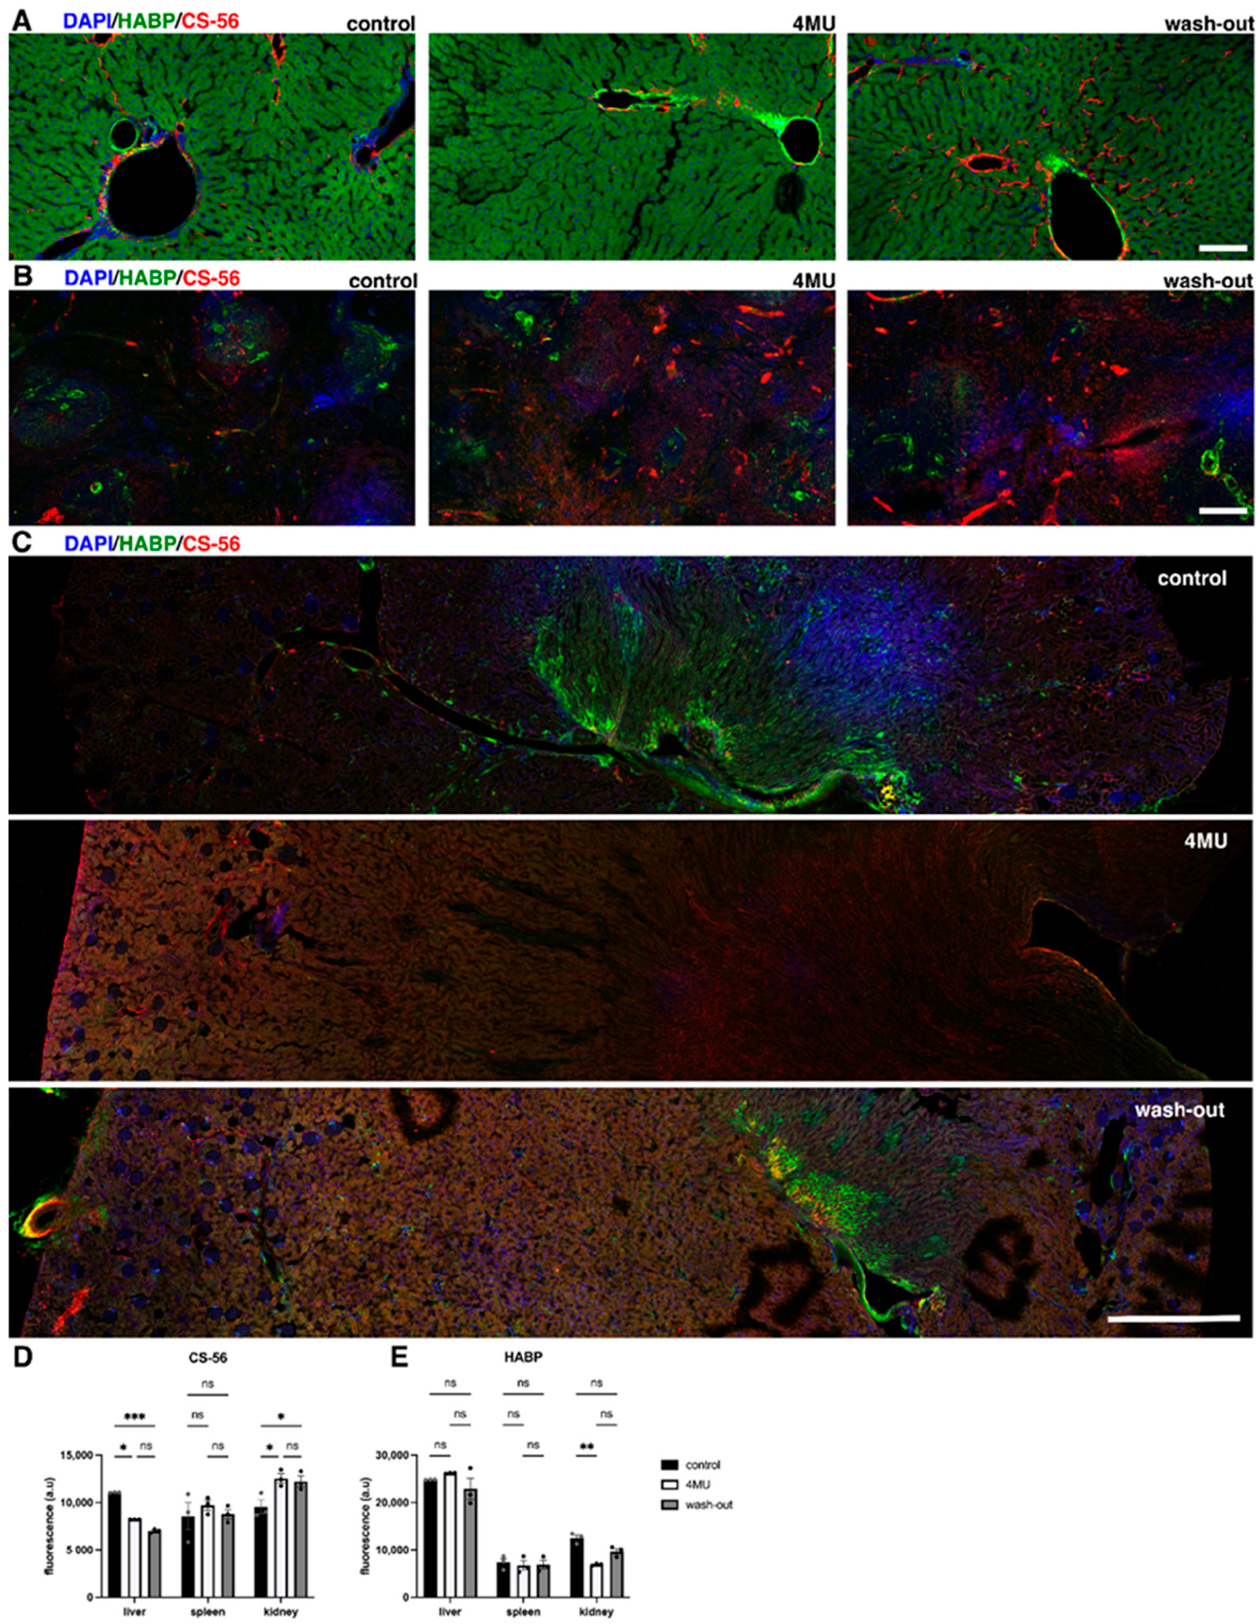
Figure 2. 4MU administered at a dose of 1.2 g/kg/day leads to downregulation of HA and CSPGs throughout the body. ( A ) Representative confocal images showing HA- and CSPG-positive areas